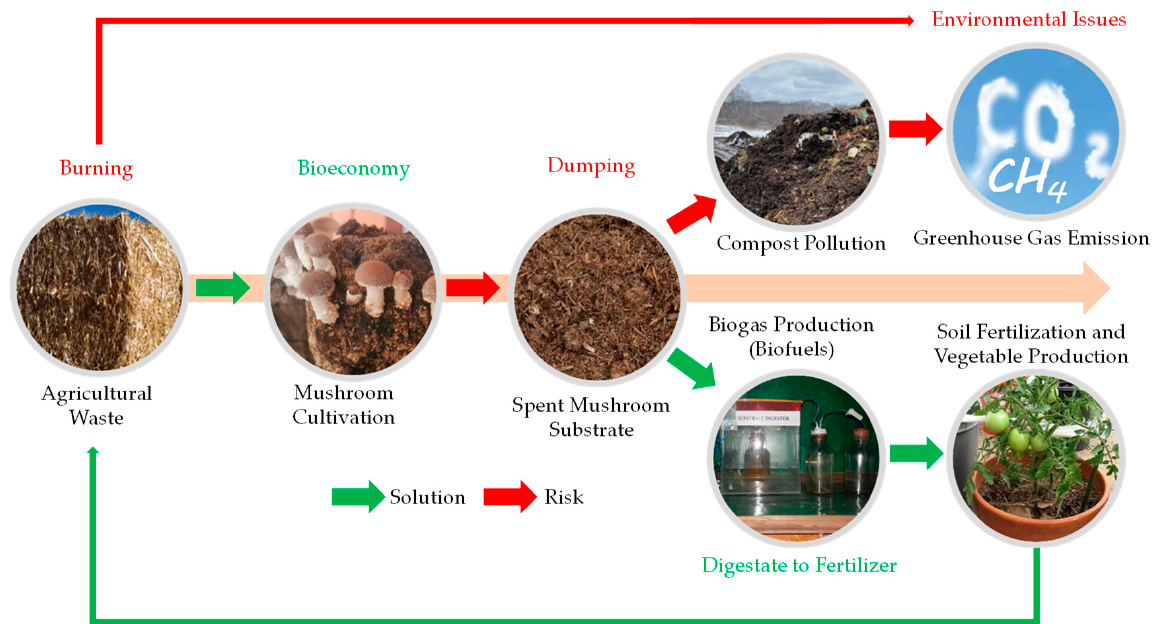
Figure 1. The circular economy concept for sustainable management of agricultural wastes through mushroom cultivation, bioenergy generation, and crop fertilization.